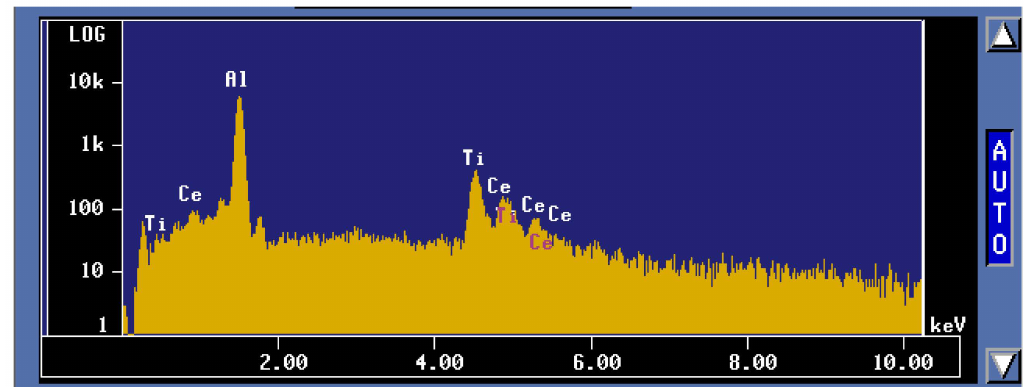
Figure 8. EDS spectrum corresponding to the gray phase observed in the BSE image in Figure 7 (CP).